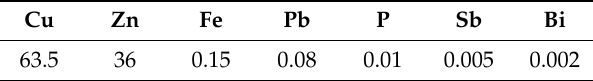
Table 2. Chemical Composition of Brass (in